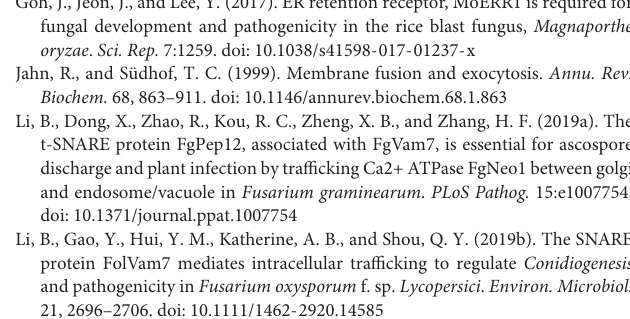
Supplementary Figure 1 | qRT-PCR analysis of expression levels of A11731 gene in (cid:49) Cfhac1 . Supplementary Figure 2 | Generation of the CfVAM7 gene deletion mutant in C. fructicola . (A) Schematic diagram of the deletion strategy for the CfVAM7 gene. (B) Primer1: CfVAM7 -5F/H855R; primer2: CfVAM7 -7F/ CfVAM7 -8R; M: DL2000 marker; -: H 2 O negative control; +: WT positive control; (cid:49) : Mutant; C: Complemented strain. Supplementary Table 1 | Primers used in this